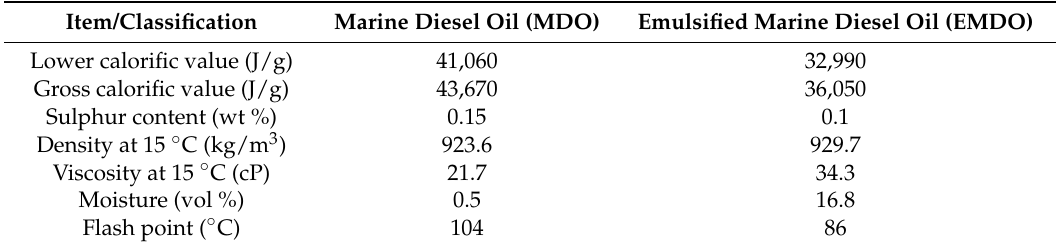
Table 2. Specifications of fuel oil used in this